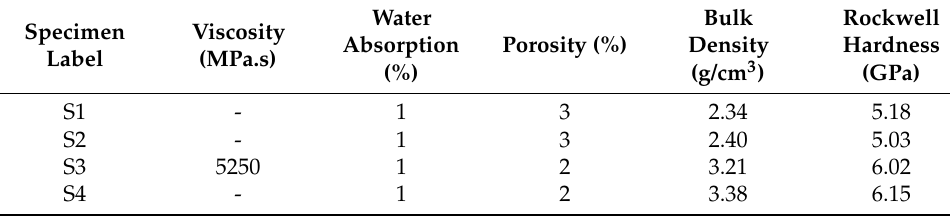
Table 10. The results of viscosity and mechanical properties at different sintering times.